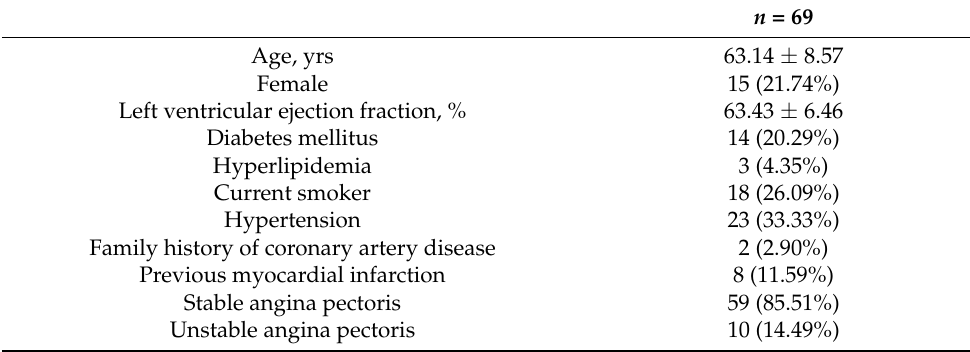
Table 1. Baseline clinical